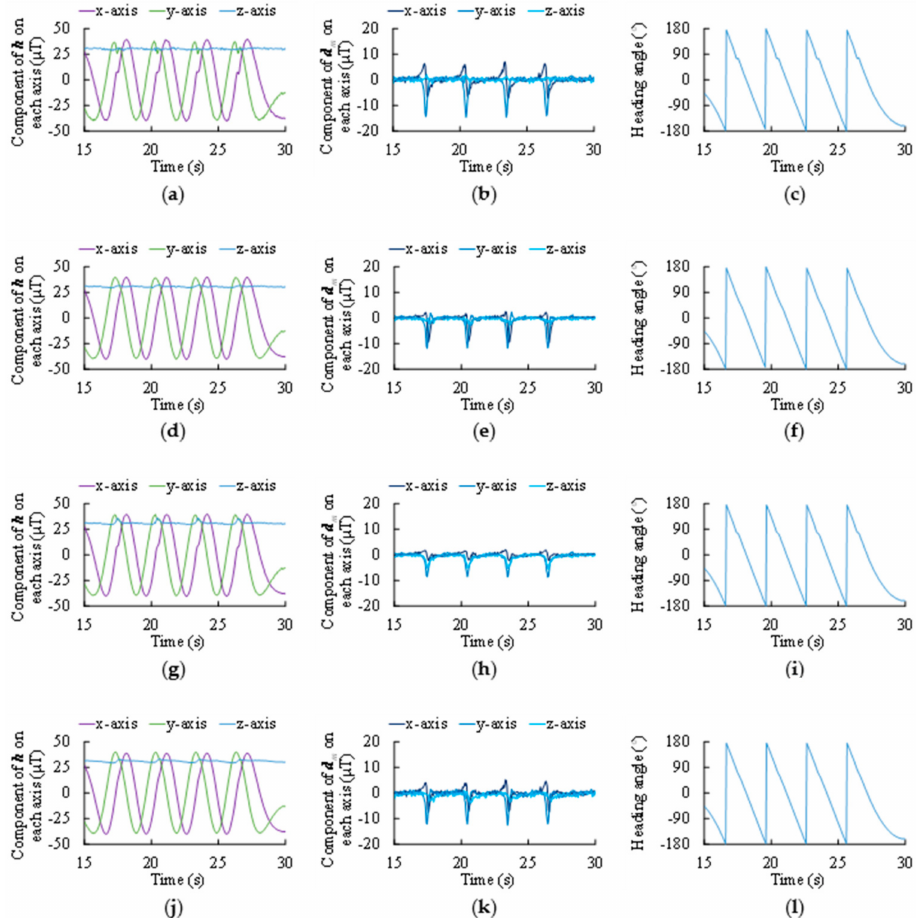
Figure 7. Estimation of geomagnetic vector h and disturbance d m , as well as the corresponding heading ( ψ ) angle. ( a ) h measurements, with uncompensated d m . ( b ) Theoretical value of d m . ( c ) ψ calculated from uncompensated h measurements. ( d ) h estimated by PA-KF with c m = 0.20. ( e ) d m estimated by PA-KF. ( f ) ψ calculated from PA-KF outputs. ( g ) h estimated by PM-KF with c m = 0.83. ( h ) d m estimated by PM-KF. ( i ) ψ calculated from PM-KF outputs. ( j ) h estimated by PM-CF with c m = 0.64. ( k ) d m estimated by PM-CF. ( l ) ψ calculated from PM-CF